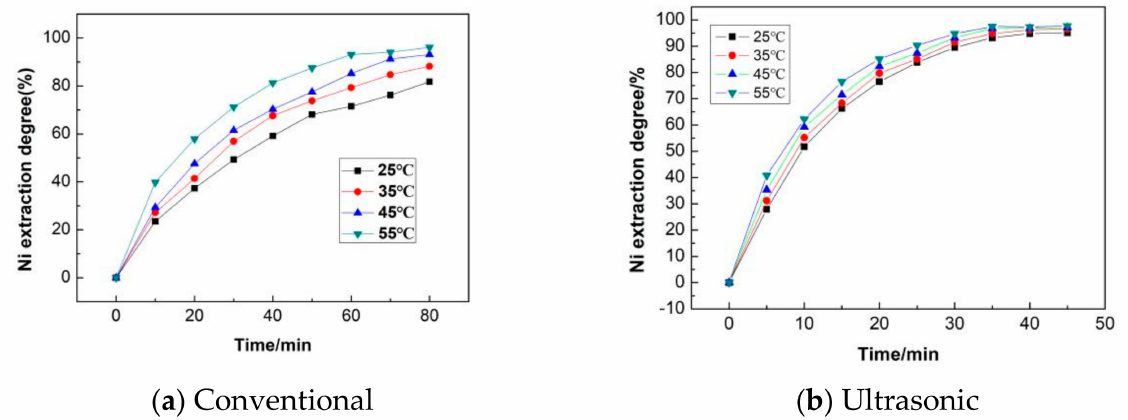
Figure 4. Influence of the temperature on the Ni extraction degree. ( a ) Conventional: mass fraction of sulfuric acid = 15%, solid-liquid ratio = 1:7, particle size = − 150 µ m, stirring speed = 150 rpm; ( b ) ultrasonic: mass fraction of sulfuric acid = 15%, solid-liquid ratio = 1:7, particle size = − 150 µ m, ultrasonic power = 600